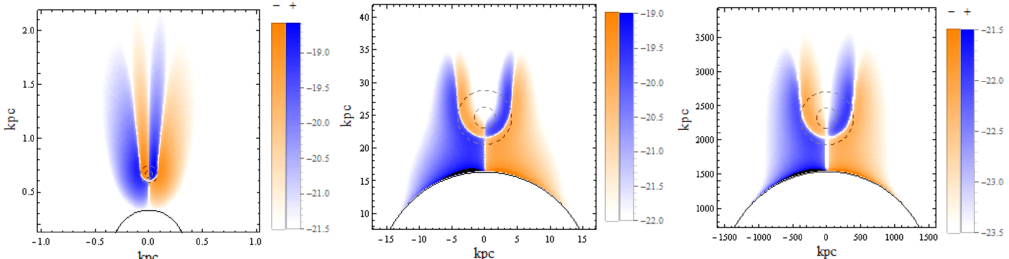
Figure 2. Strength and spatial configuration of the magnetic fields induced by the radiation of ( a ) Population III stars at z ∼ 20, ( b ) a primeval galaxy at z ∼ 10, and ( c ) a quasar at z ∼ 10. In each panel, the blue areas correspond to the magnetic field pointing toward the reader, orange in the opposite direction. This peculiar geometrical configuration of the fields simply reflects the axisymmetry of the matter distribution with respect to the ionizing source. Strengths are in Gauss in logarithmic scale. The solid line arc represents the edge of the H II region created by the ionizing source (not shown). Inner and outer dashed black circles delineate, respectively, the one sigma location of the overdensity and of the compensating underdensity (the latter being responsible for the reversal of the magnetic field). Note that the scales change from panel to